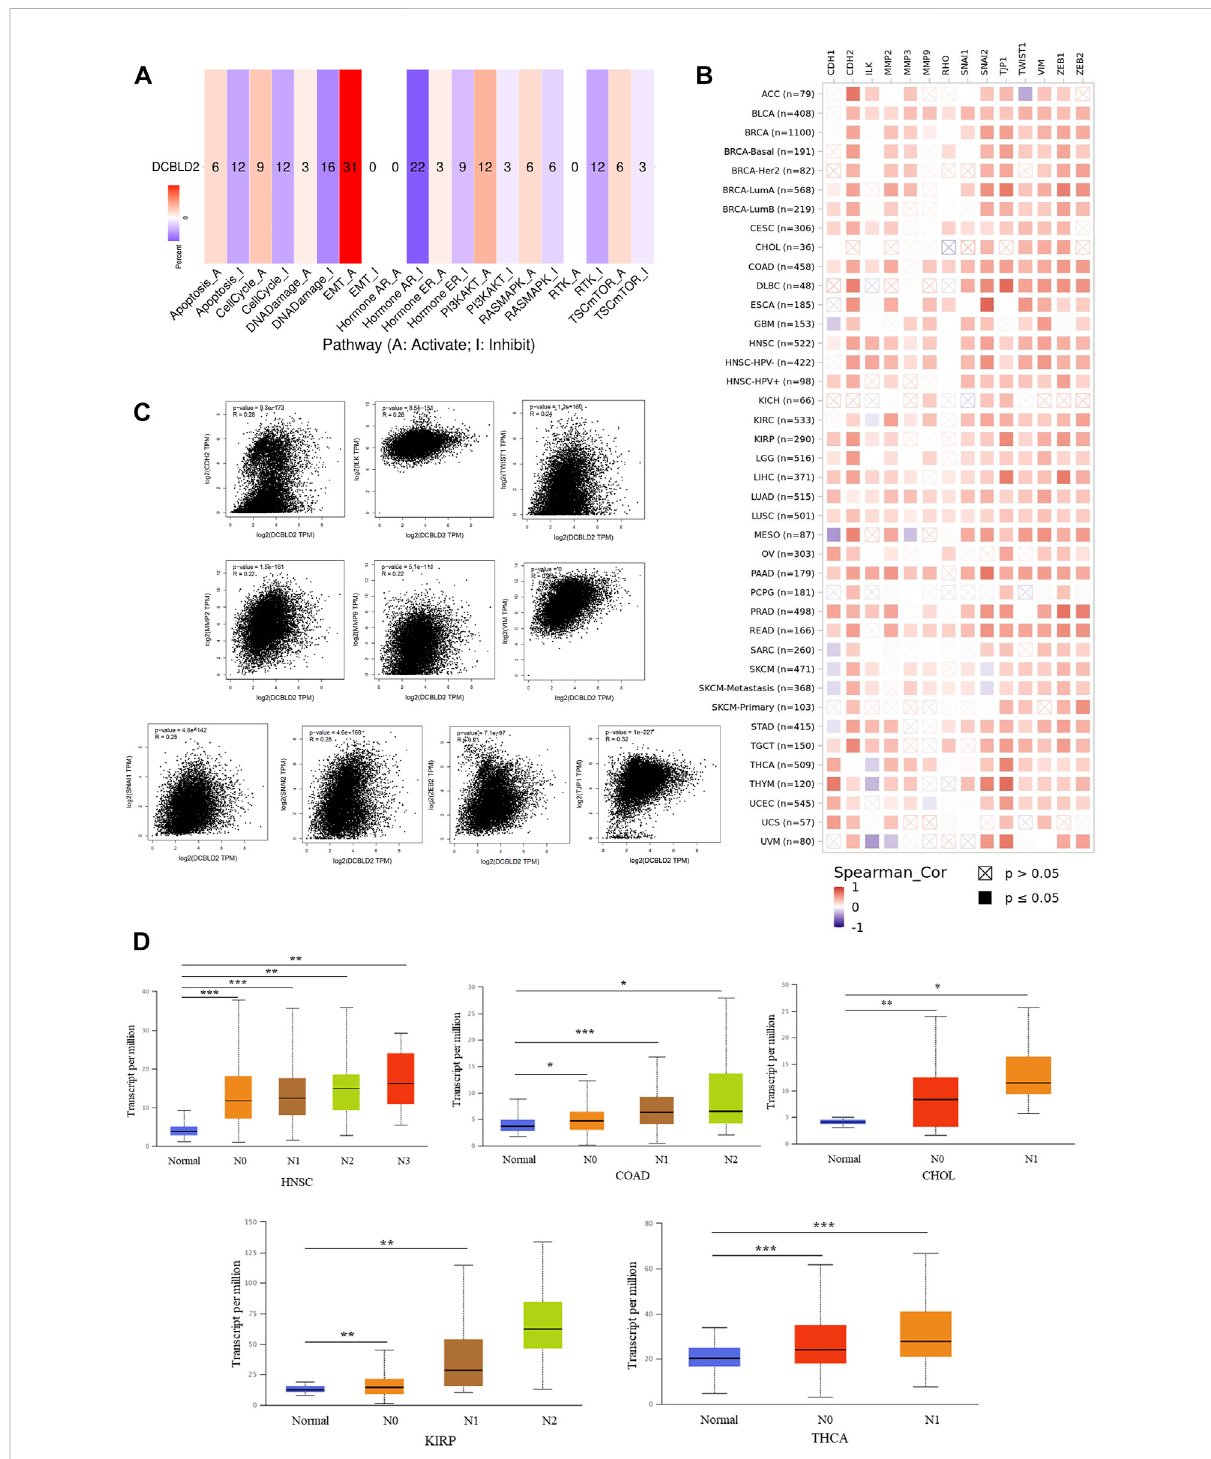
FIGURE 4 The association of DCBLD2 with EMT signal activation. (A) The percentage of cancers in which mRNA expression of DCBLD2 has a potential effect on pathway activity (A: Activate; I Inhibit). (B) The correlation heatmap of DCBLD2 and the key regulators of EMT signal in the detailed cancer types. (C) Analysis of the association between the expression of DCBLD2 and EMT signal regulators, including CDH2 , ILK , MMP2 , MMP9 , SNAI1 , SNAI2 , TJP1 , TWIST1 , VIM , and ZEB2 usingtheGEPIA2 approach.Only targetinggenes withstatisticallysigni fi cantcorrelationarepresented. (D) For the type of HNSC, COAD, CHOL, KIRP and THCA in the TCGA project, the box plot data of differential DCBLD2 expression levels (log2 x + 1) between N stages (Normal, N1, N2, and N3) were supplied. * p < 0.05, ** p < 0.01, ** p <